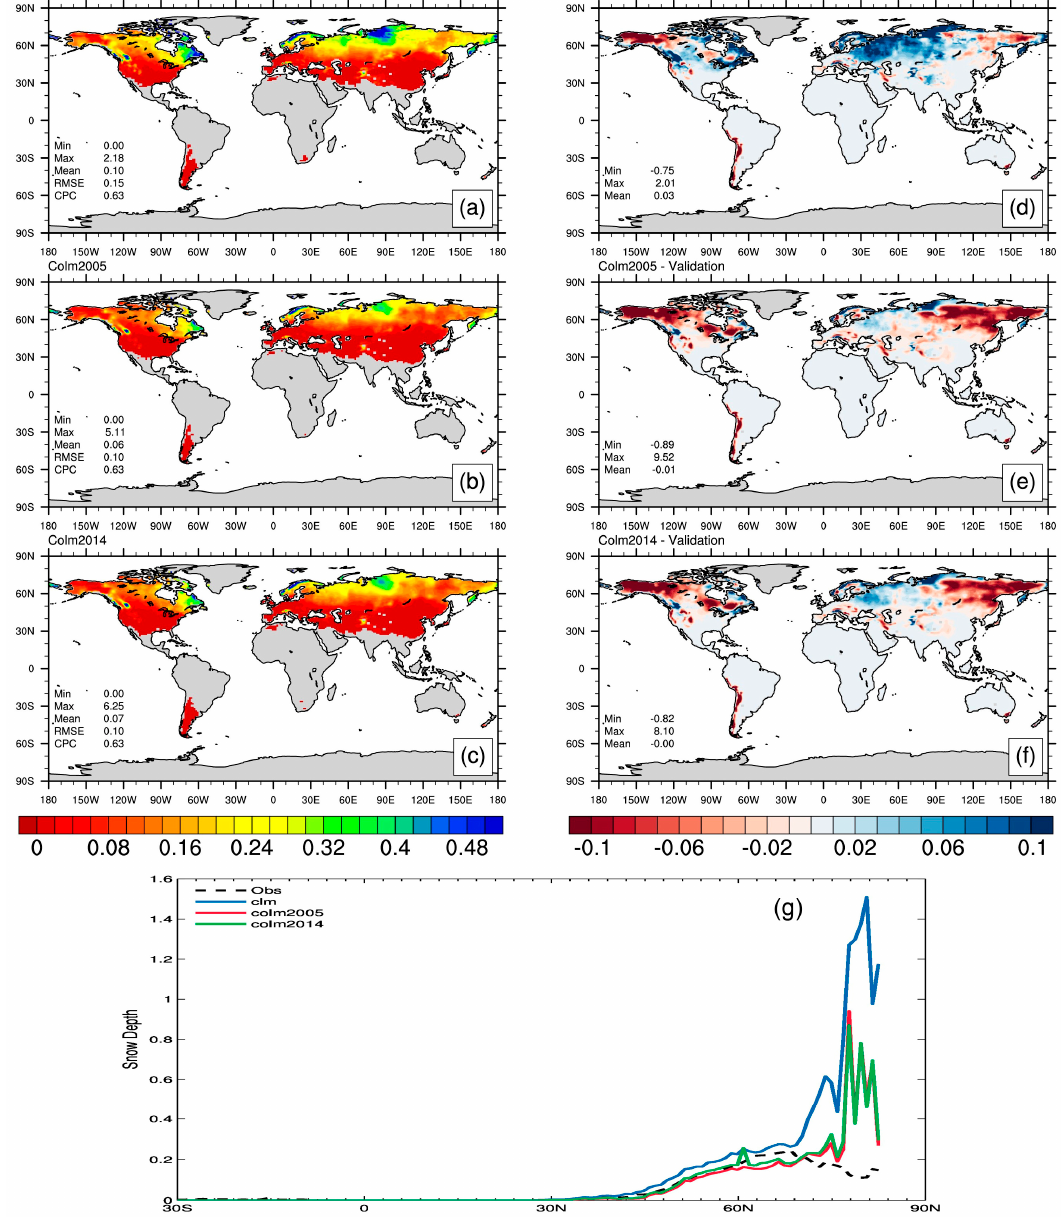
Figure 5. Annual mean spatial distributions of snow depth simulated by ( a ) CLM4.5; ( b ) CoLM2005; and ( c ) CoLM2014; Along with spatial distributions of biases relative to the validation standard for ( d ) CLM4.5; ( e ) CoLM2005; and ( f ) CoLM2014; Panel ( g ) shows zonal mean snow depth from validation observations (black dashed line) and the CLM4.5 (blue), CoLM2005 (red), and CoLM2014 (green) simulations (Units: m).